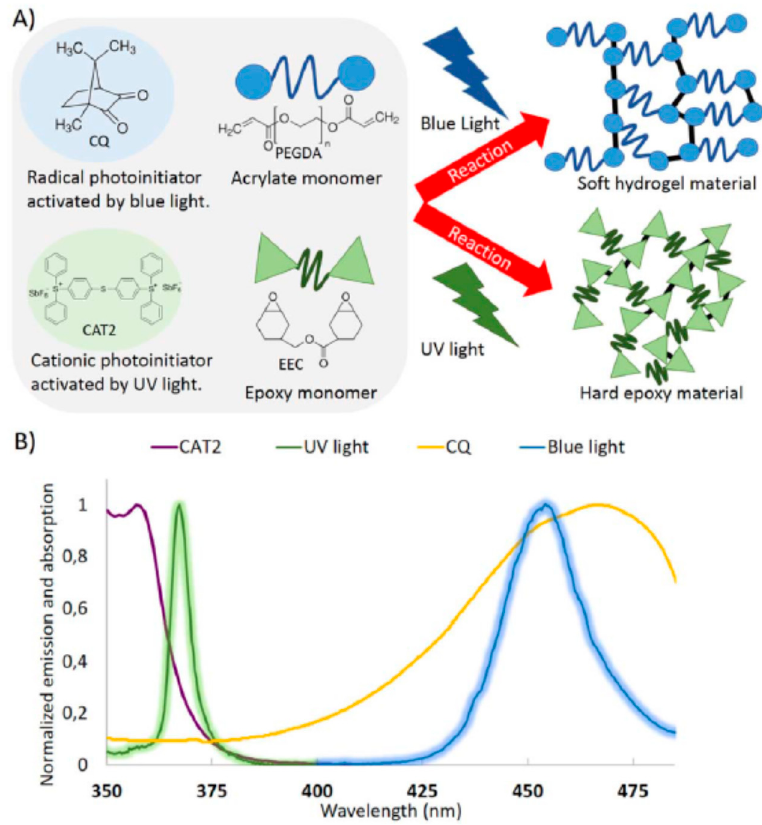
Scheme 11. ( A ) Reaction schemes for photoinitiation of radical mediated acrylate homopolymerization and cationic epoxy homopolymerization. ( B ) Normalized emission spectra of the light sources used for initiating the reactions. Reprinted (adapted) with permission from